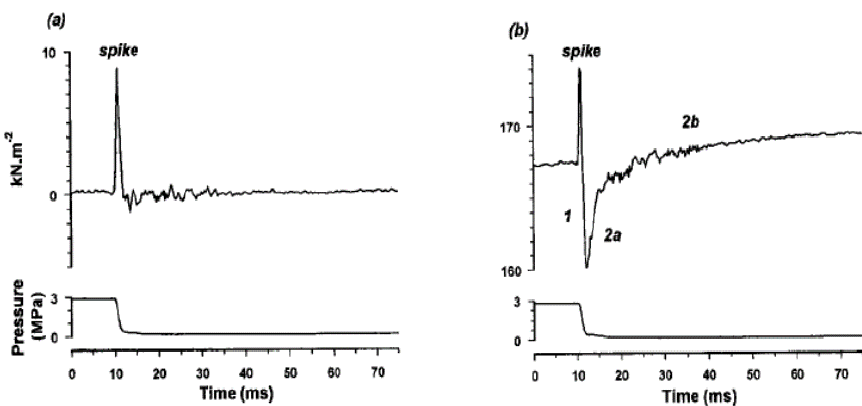
Figure 15. Tension transients induced by rapid pressure release, from a single muscle fibre at ~4 °C (the steady hydrostatic pressure was increased to ~3 MPa and rapidly released (<1 ms) to atmospheric level). ( a ) The resting tension is largely unaffected by the perturbation; the spike on the tension trace is probably a transducer response to rapid decompression. ( b ) Response of the active fibre: pressure release made on the plateau of the tetanus. In addition to the spike (as in a) is a tension drop (Phase 1), followed by a rapid recovery and rise (Phase 2a and 2b) to a level higher than that prior to release (from Vawda et al., 1999, [20]).